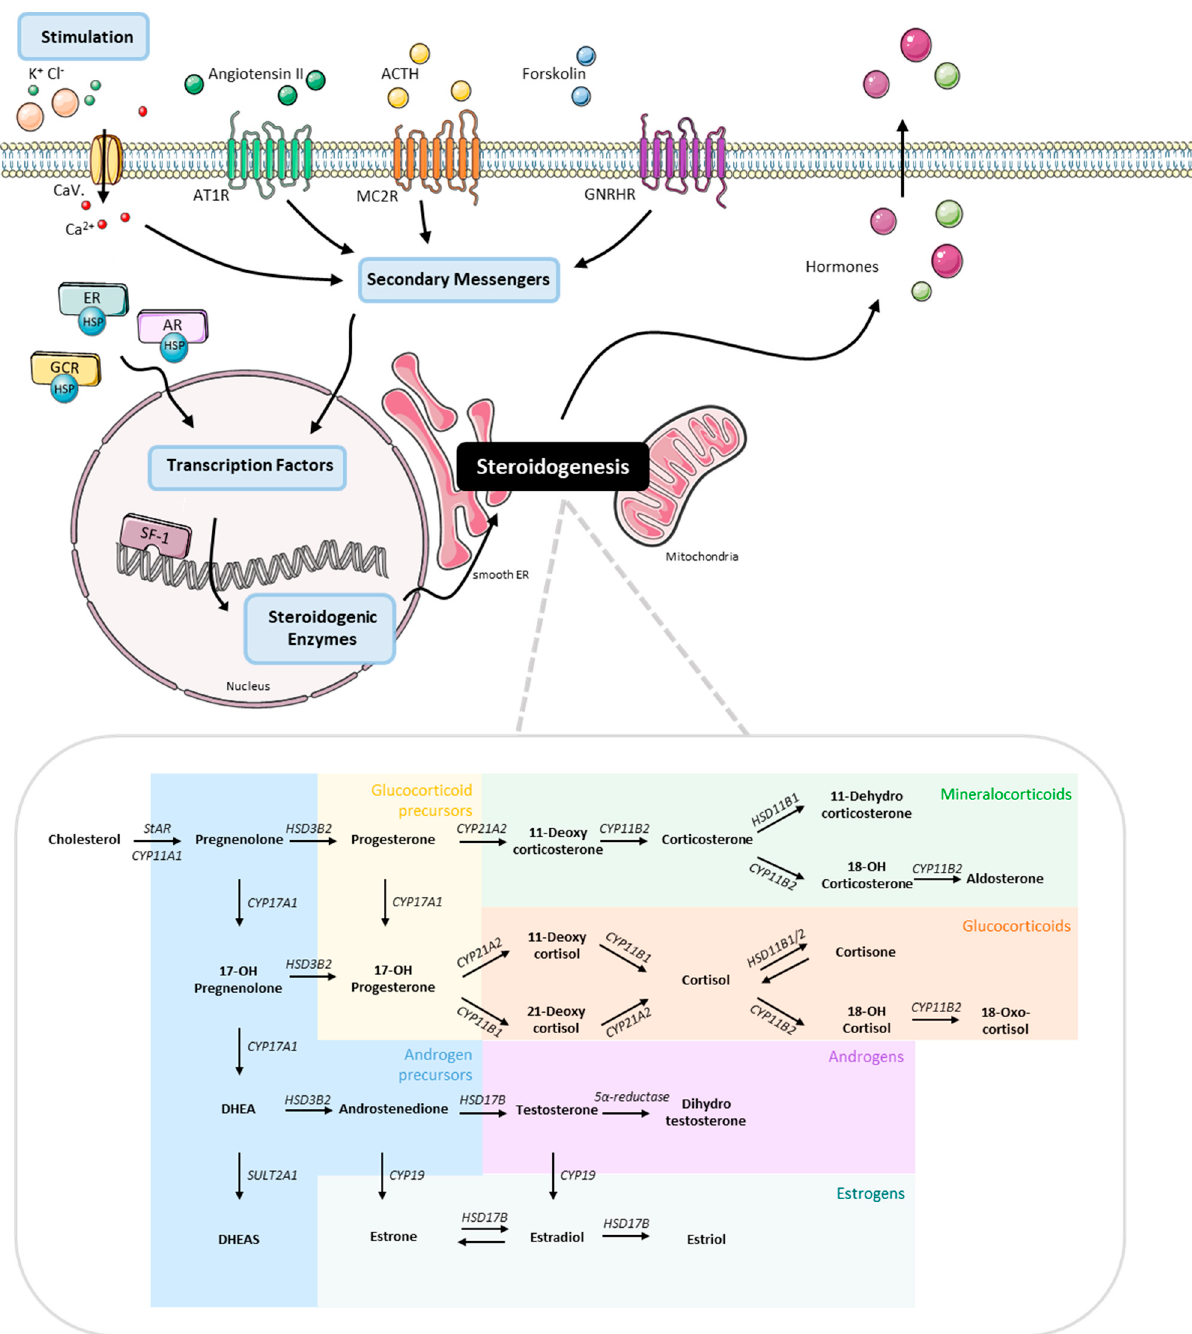
Figure 1. Schematic representation of steroidogenesis pathway from stimulation to hormone pro- duction. Figures have been created modifying an image set from Servier Medical Art (SMART) http://smart.servier.com/ (accessed on 19 July